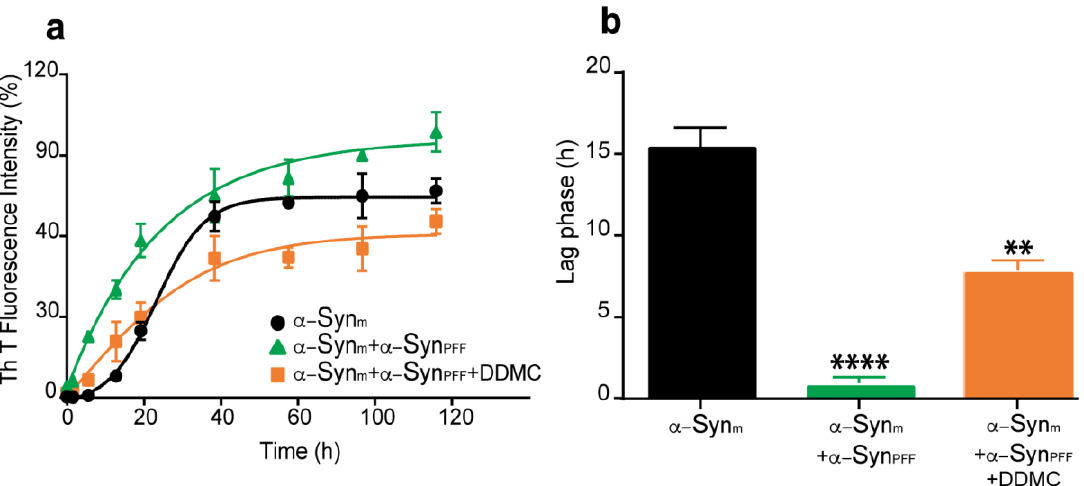
Figure 3. Effect of DDMC on α-Syn seeding induced by externally added α-Syn PFF . ( a ) The fluorescence emission intensity of 25 μM ThT as a function of time (0-120 hr) in a solution containing 70 μM monomeric α-Syn (α-Syn m ) alone (black circles) or seeded with α-Syn PFF (α-Syn m +α-Syn PFF ) in the absence (green triangles) or presence of DDMC (α-Syn m +α-Syn PFF +DDMC) (orange squares) after 120 h of incubation. For each time point, data values represent the mean + SEM. ( b ) Lag phase quantification based on the kinetics of aggregation of the seeding assay as described in Materials and Methods. Statistical significance is indicated as: **** p < 0.01; ** p < 0.01 vs. α-Syn m .